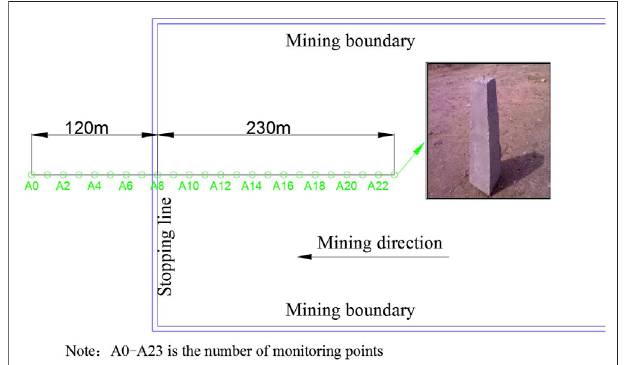
FIGURE 3 | Layout and distribution of monitoring points.